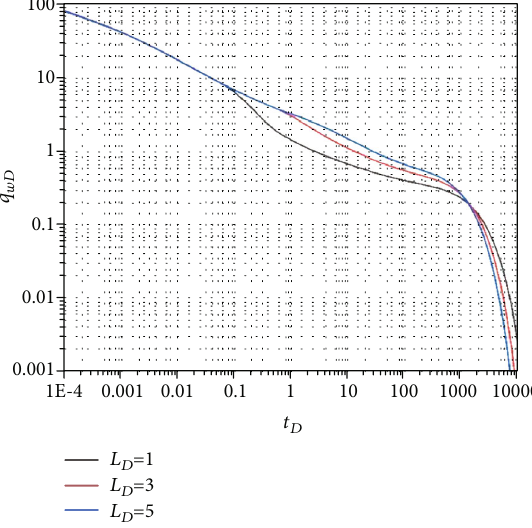
Figure 5: In fl uence of di ff erent LD on